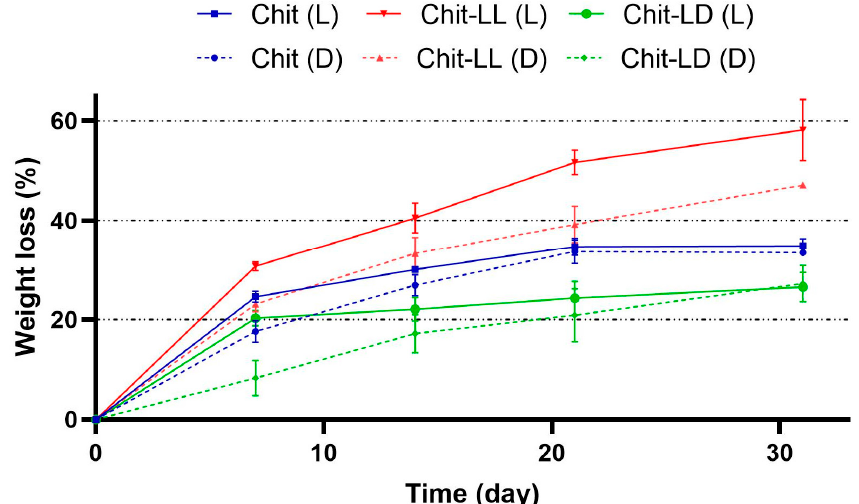
Figure 4. Degradation kinetics of the macroporous hydrogel samples from chitosan (Chit), chitosan- g-oligo(L,L-lactide) (Chit-LL), and chitosan-g-oligo(L,D-lactide) (Chit-LD) copolymers after their incubation in DMEM (D) or in lysozyme (L) (2 mg/mL) for 31 days at 37 °C. Data are expressed as the mean ± SD. All experiments were performed in triplicate.